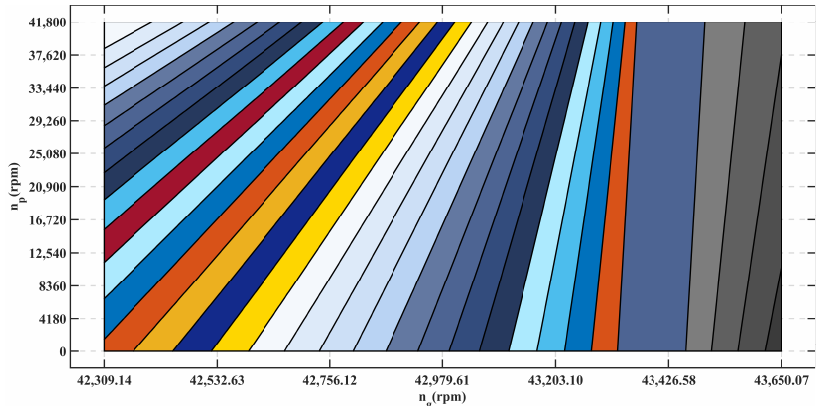
Figure 5. The partition of state space: N y =